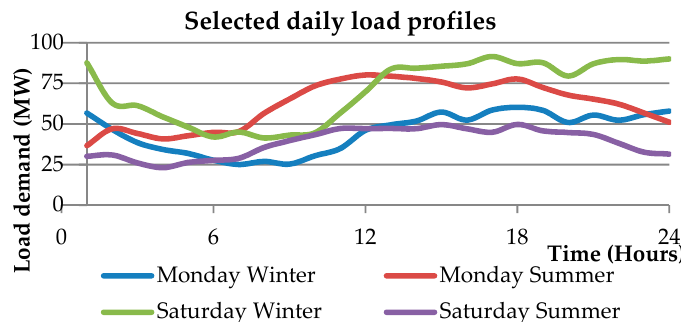
Figure 5. Selected daily load profiles over summer and over winter for the study.